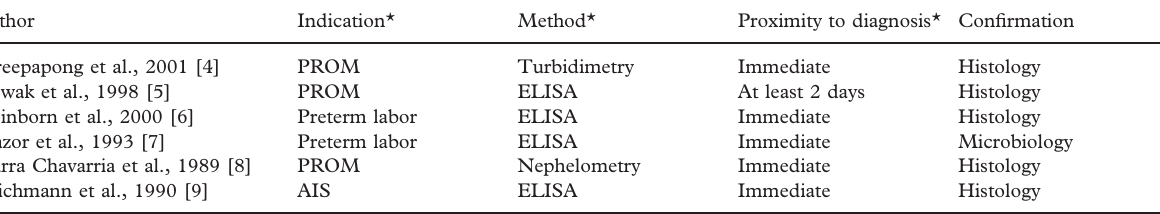
Table II. Details of maternal serum CRP measurement in previous reports on its diagnostic properties compared with histological or microbiological investigations in detection of chorioamnionitis.